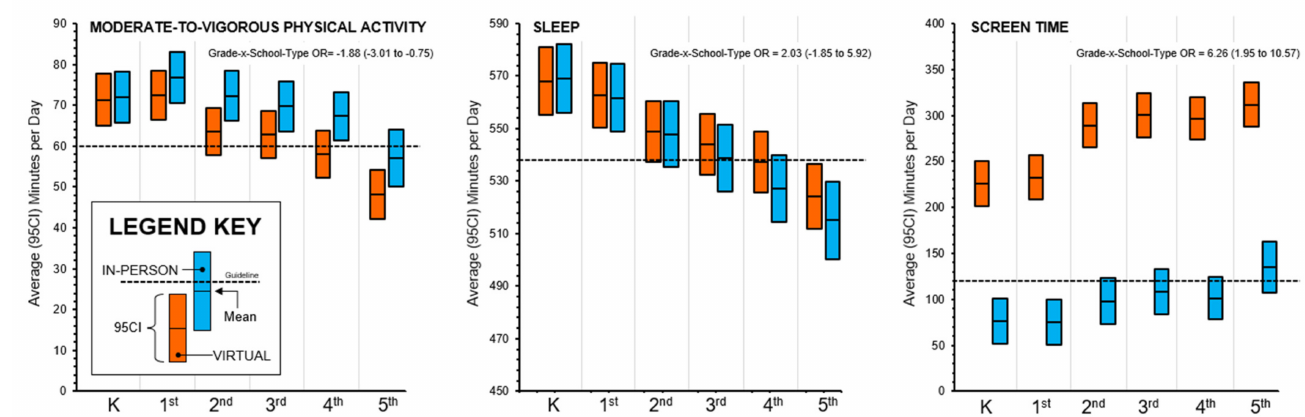
Figure 1. Average (95% confidence intervals) minutes spent in each movement behavior while attending virtual (orange) or in-person (blue) school for elementary-age children during the